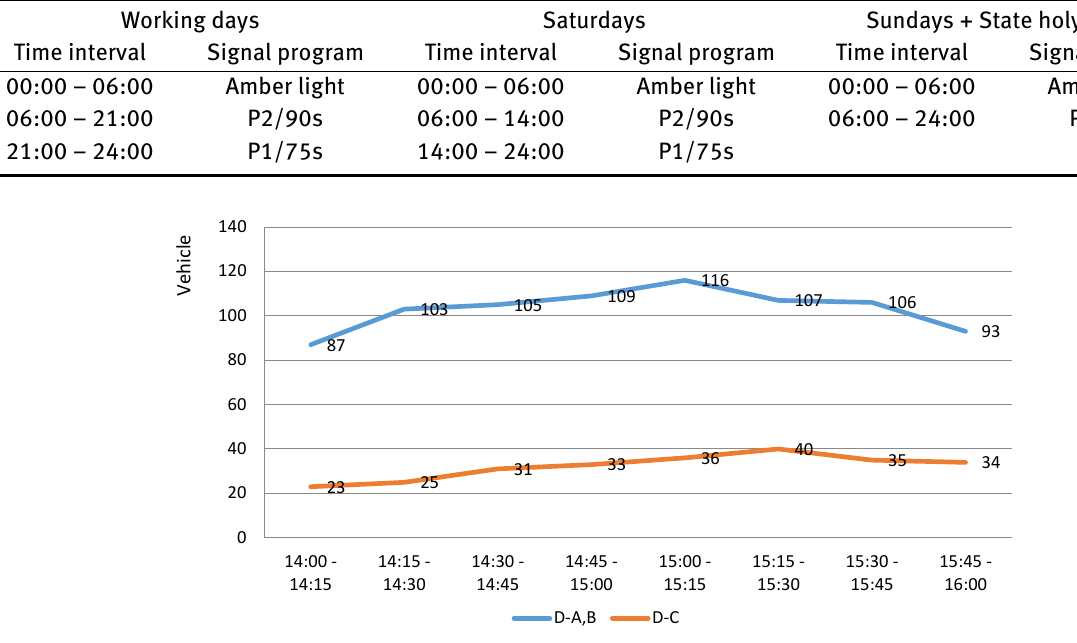
Figure 3: Number of vehicles crossing the intersection from direction D